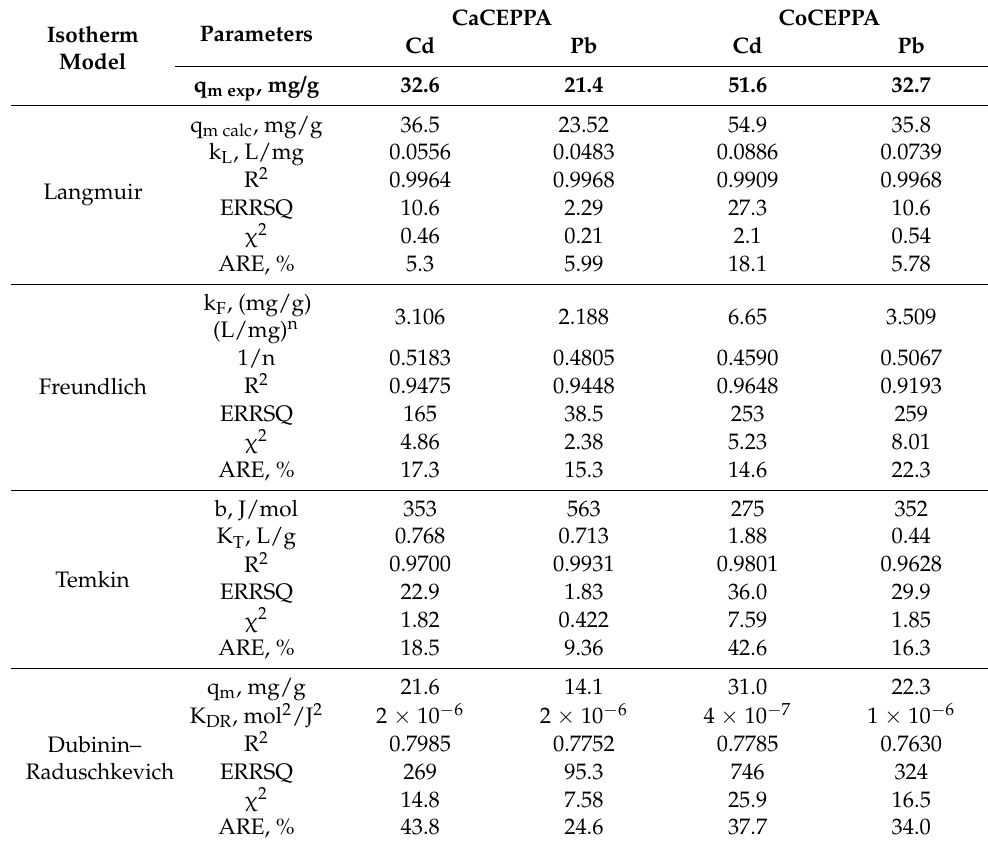
Table 2. Langmuir, Freundlich, Temkin, and Dubini–Raduschkeich isotherm parameters for Cd 2+ and Pb 2+ adsorption from aqueous solutions onto CaCEPPA and CoCEPPA